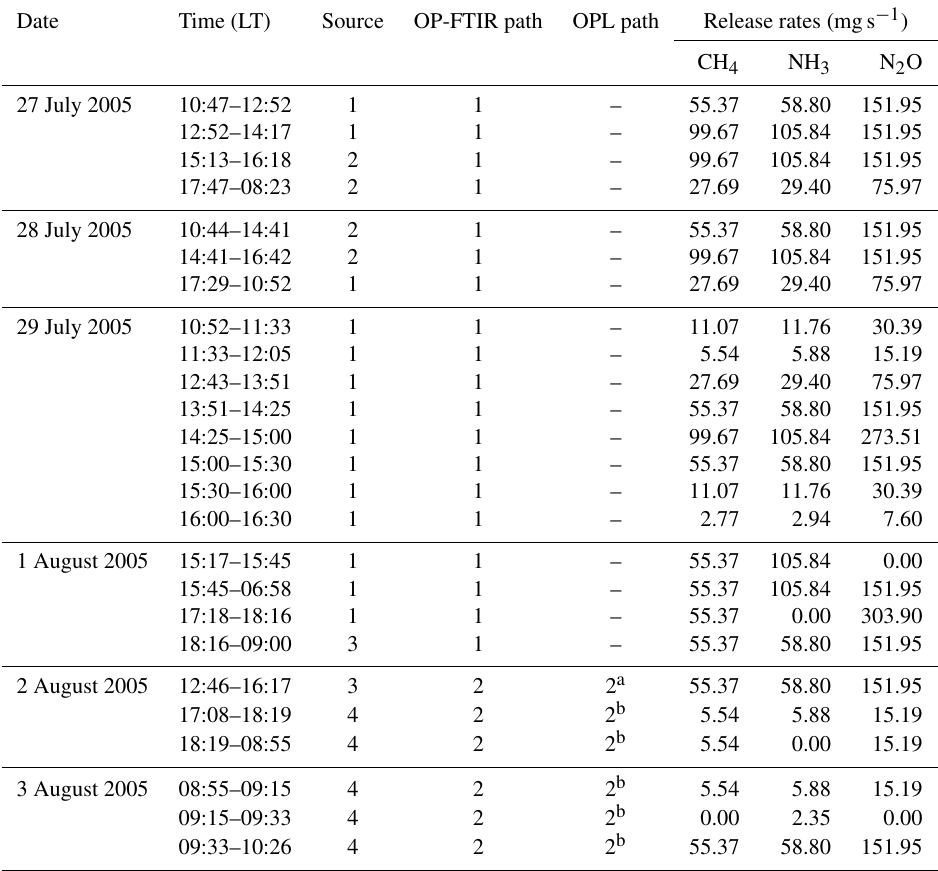
Table 2. Gas release times, rates, and source types for controlled release experiments at Kyabram DPI (July–August 2005). Mass flows measured in standard litres per minute (21 ◦ C and 1atm) have been converted to milligrams per second (mgs − 1 ). LT denotes local time.